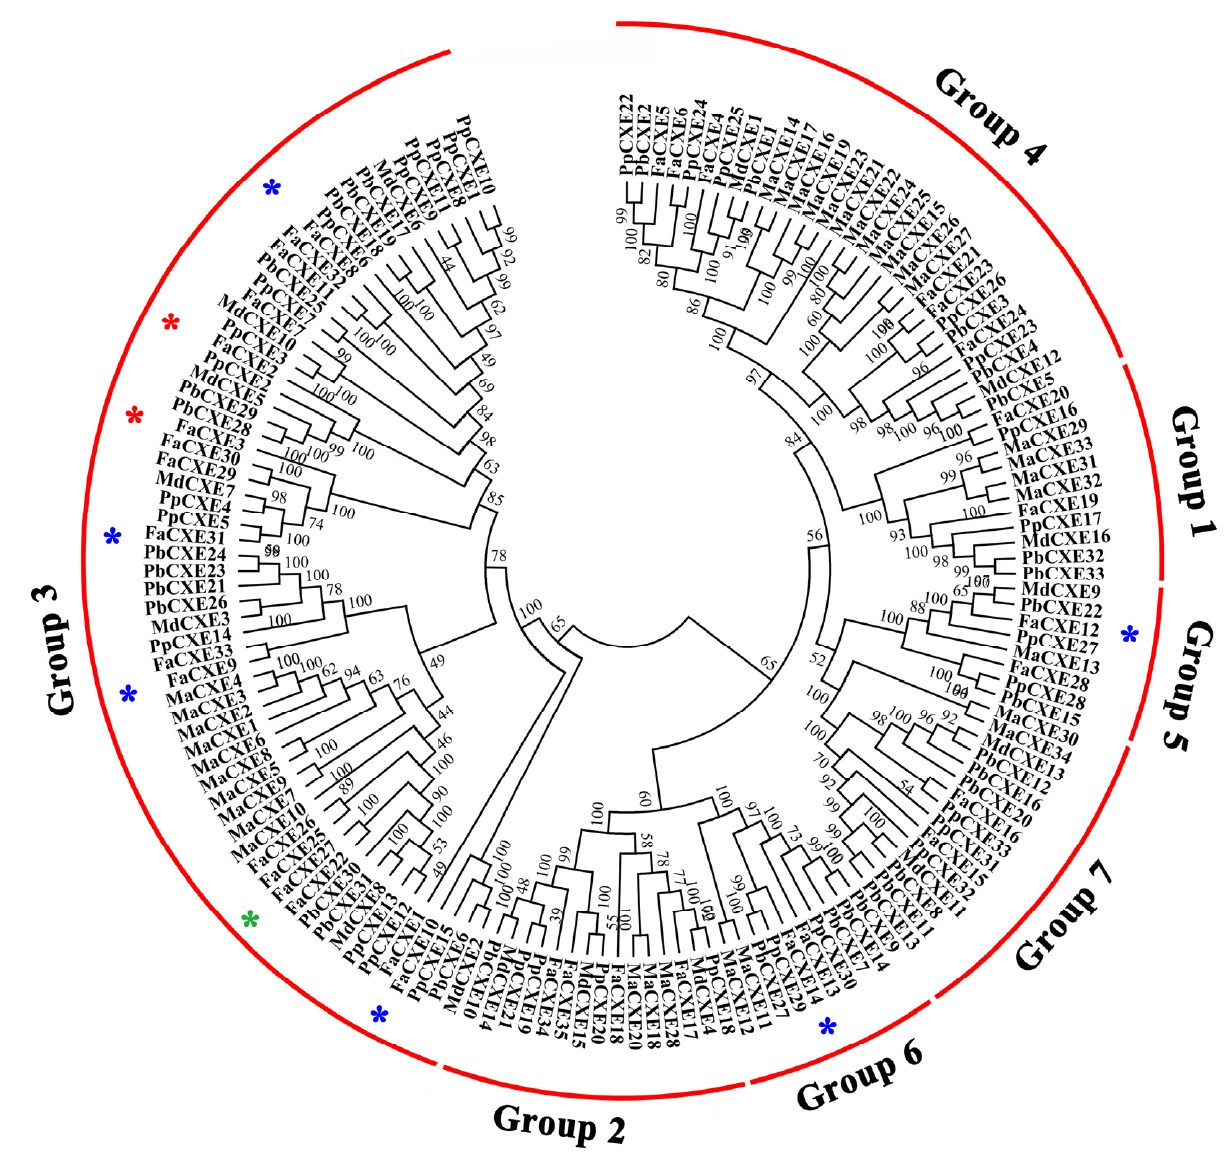
Figure 3. Phylogenetic tree of CXE genes from the five plants. Fa represents strawberry; Ma represents banana; Md represents apple; Pb represents pear; and Pp represents peach. The phylogenetic tree was constructed using the full-length amino acid sequences of selected CXEs by NJ methods. All CXEs from the five plants, including strawberry, banana, apple, pear, and peach were classified into 7 groups. The function of FaCXEs, marked with red asterisks, were identified in this study. The function of FaCXE27 (FanCXE1), marked with green asterisk, was identified in earlier study [33]. Red, green and blue asterisks denote the FaCXE genes selected for expression.